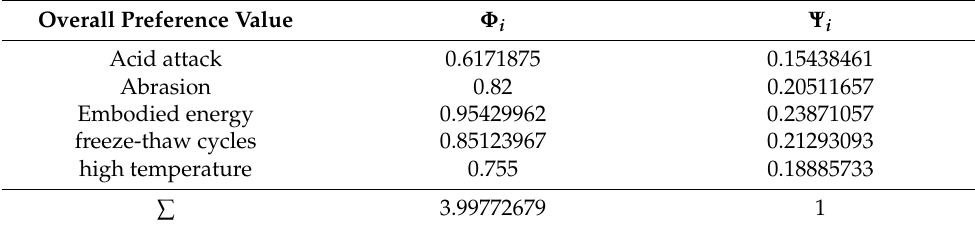
Table 6. Computed overall preference value.